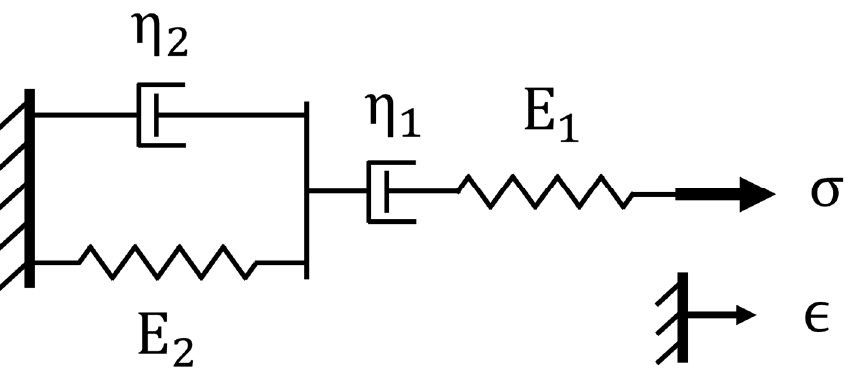
Figure 2. Burger’s rheological model of viscoelastic materials. The spring and damper in parallel (E 2 and η 2 ) capture the senor’s viscoelastic behavior, the spring in series (E 1 ) models the elastic behavior, and the damper in series ( η 1 ) accounts for the viscoplastic behavior.